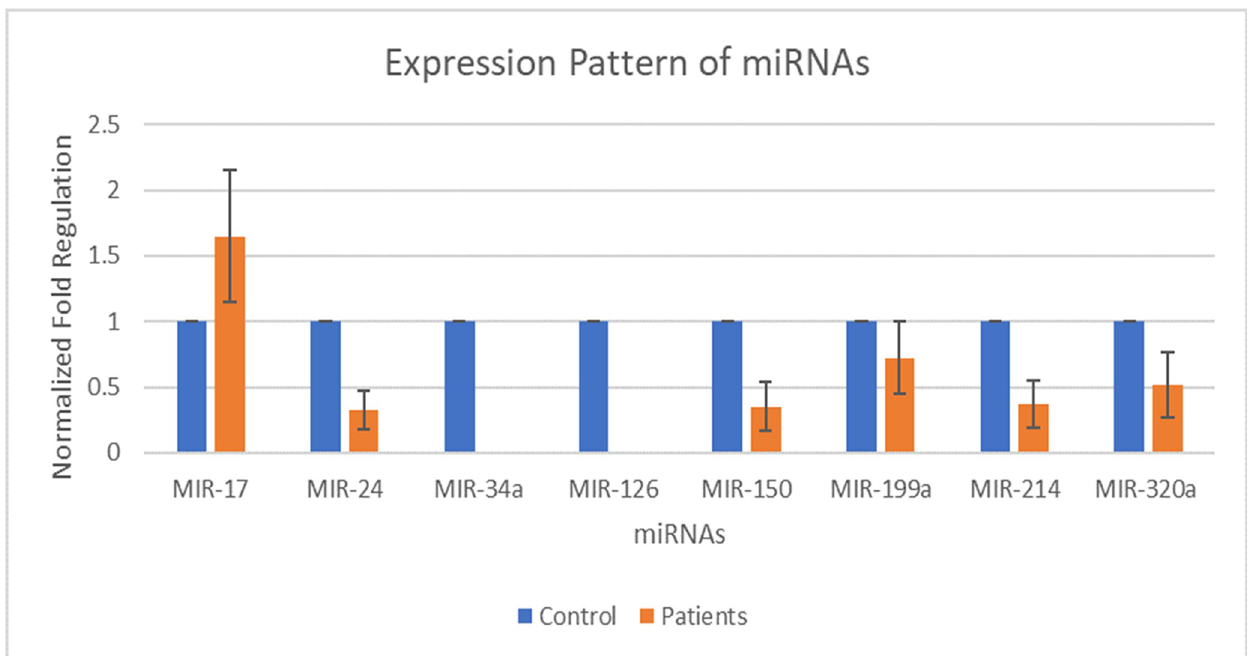
Fig 2. Expression pattern of miR-17, miR-24, miR-34a, miR-126, miR-150, miR-199a, miR-214, and miR-320a during type 2 diabetic cardiomyopathy. X-axis presenting the miRNAs along with the control and patients’ group. Y-axis is presenting the fold increase or decrease in expression. Error bars indicating the standard deviation from the